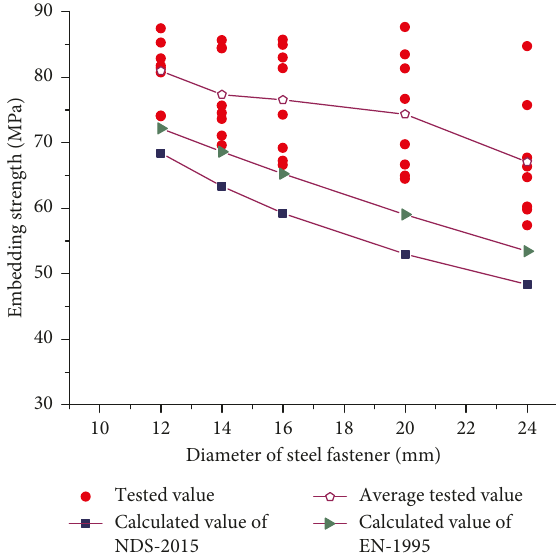
Figure 12: The comparison between the tested value and theo- retical